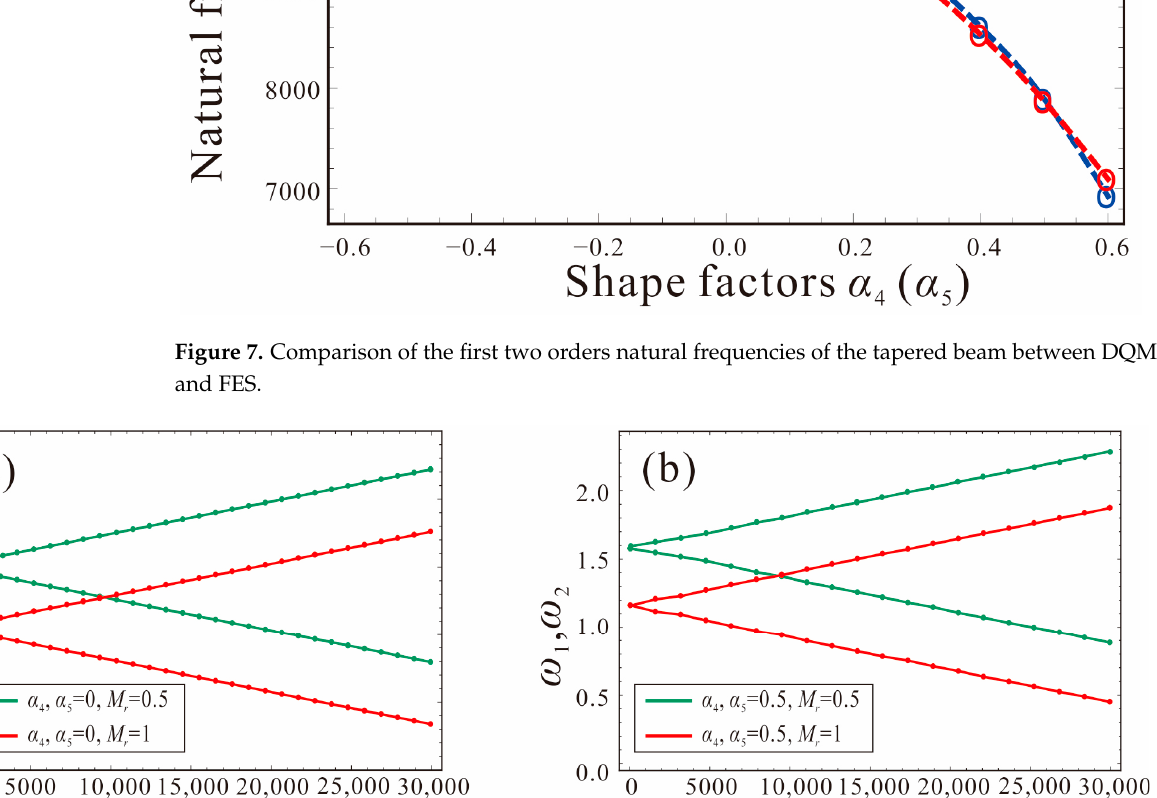
Figure 7. Comparison of the first two orders natural frequencies of the tapered beam between DQM and FES.